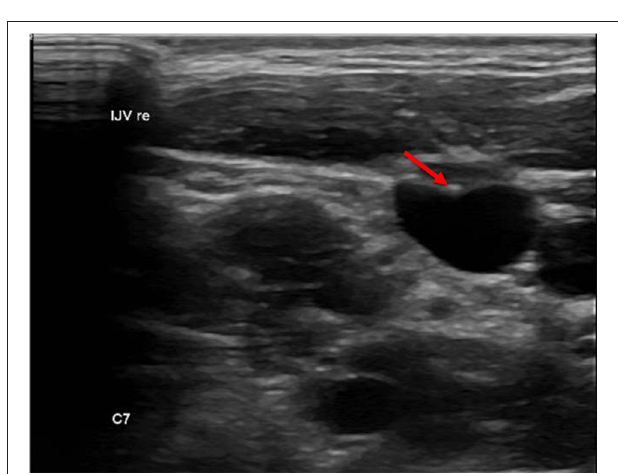
FIGURE 2 | Endothelial lesion. Lesion at the catheter’s former entry site of the vessel (red arrow).